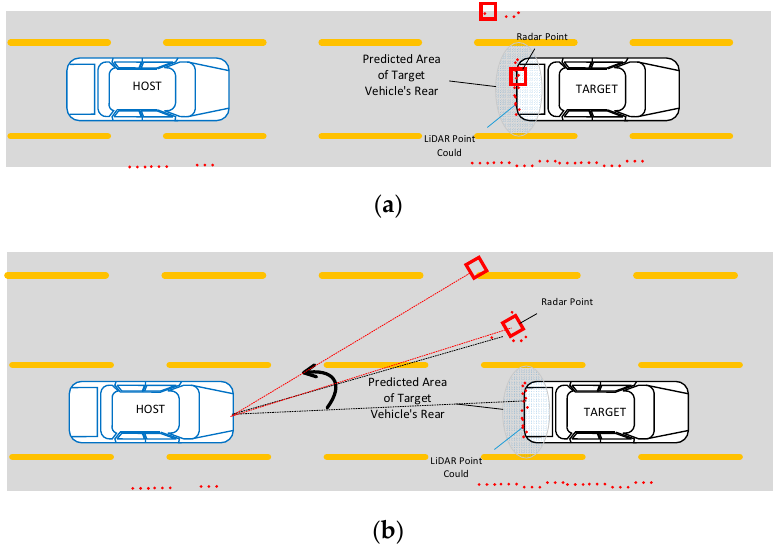
Figure 8. Fault Isolation: ( a ) Mode A; ( b ) Mode B.